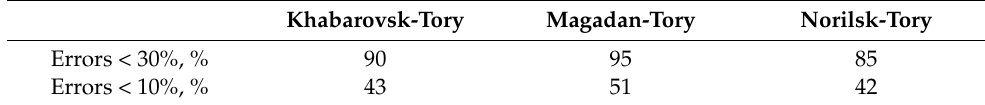
Table 1. Errors of MUH estimates for different radio paths.